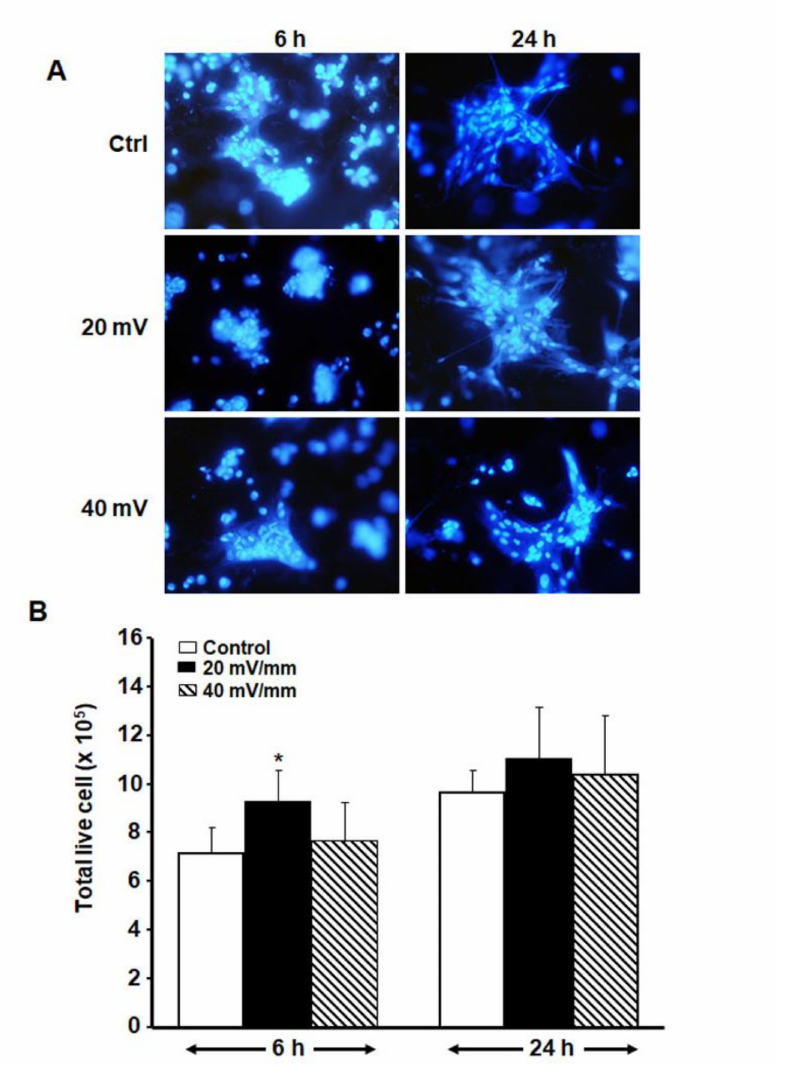
Figure 5. Effect of low-intensity ES on DHSF adhesion and growth. ( A ) Cells on the conductive membrane after 6 or 24 h of ES, with a morphology similar to that in the control. ( B ) Following exposure to ES for 6 or 24 h, then culture for an extra 48 h, the cells were detached from the membranes by means of a 0.05%-trypsin-0.01 EDTA solution and cell suspensions were subjected to a trypan blue exclusion assay to count non-stained (viable) cells using a hemocytometer. * p < 0.05. Note the high number of live cells showing the beneficial effect of ES on cell adhesion/growth, basically at 6